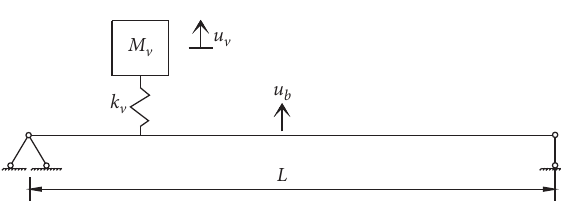
Figure 35: Beam with the moving spring